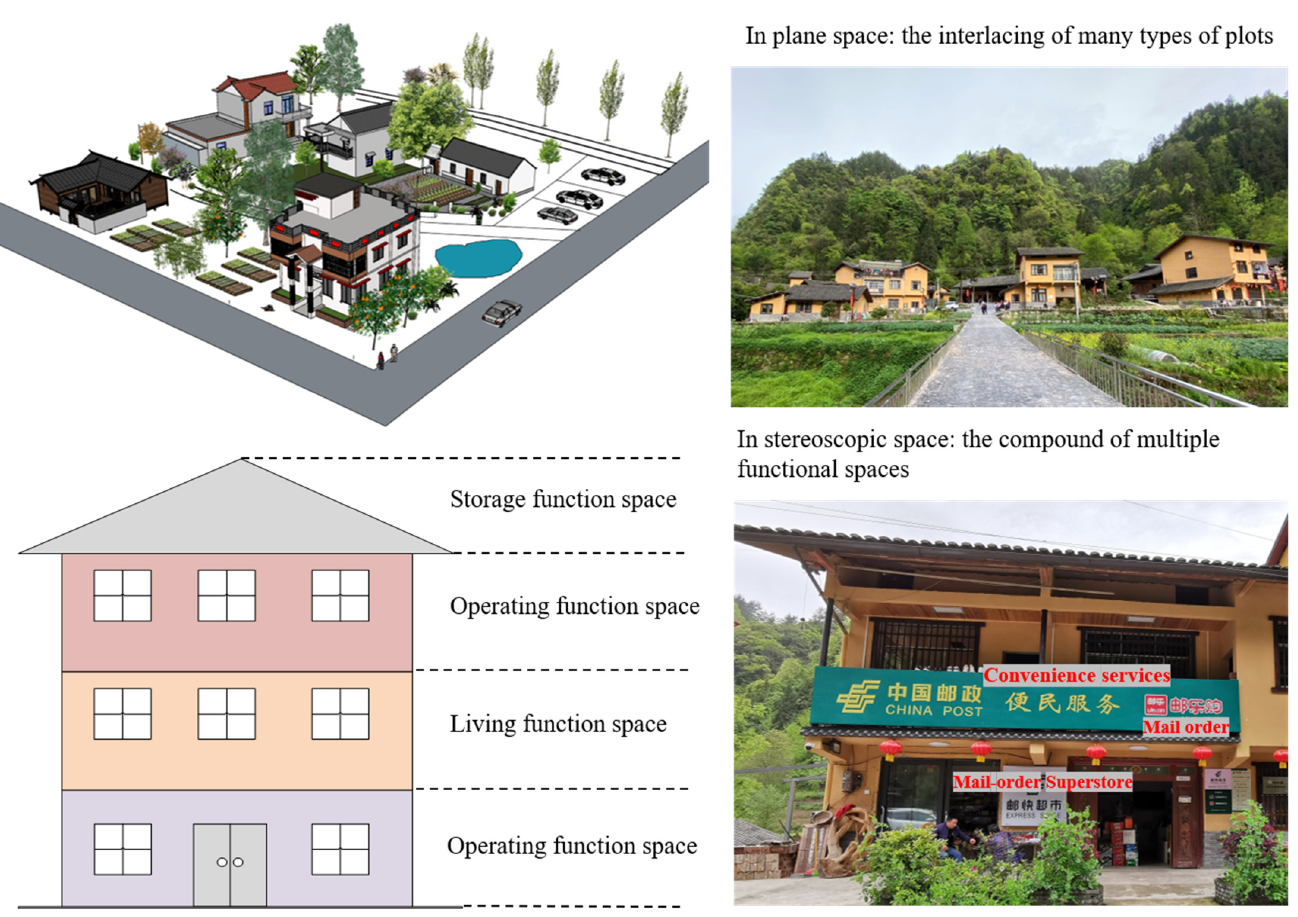
Figure 2. The conceptual model and real landscape structure of MLUs in rural settlements. (2) The Measurement System of MLU Levels Table 3. Measurement system of MLU in rural